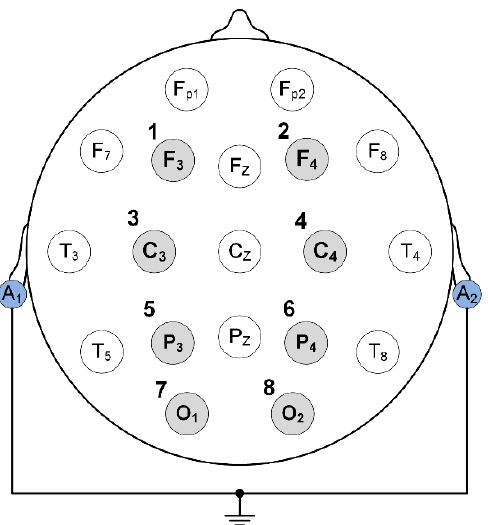
Figure 4. Unipolar electrode configuration for measurement of brain activity.